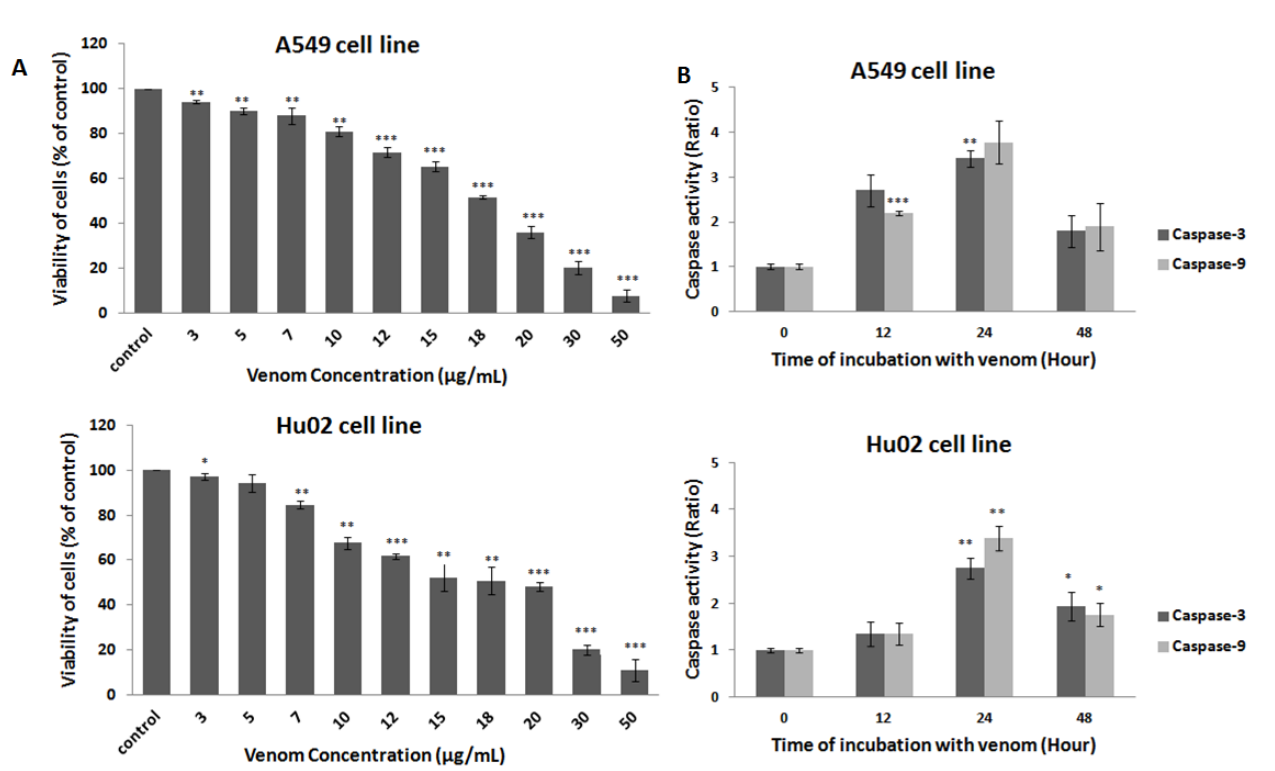
Figure 2. Effects of P. persicus venom on cell viability and caspase-3 and caspase-9 activities compared to untreated cell. ( A ) Cytotoxic activity of P. persicus crude venom on A549 and Hu02 cells after 24 hours of treatment with different venom concentrations. The viability of cells was estimated by MTT assay. ( B ) Activities of caspase-3 and caspase-9 enzymes in A549 and Hu02 cells after venom treatment. The cell lines were treated with IC50 concentrations of P. persicus venom for 12, 24 and 48 hours and harvested separately. Activities of caspases were determined by substrate cleavage assay. All data were presented as mean ± S.D (n = 3). Statistical significance versus control (*p < 0.05; **p < 0.01; ***p <